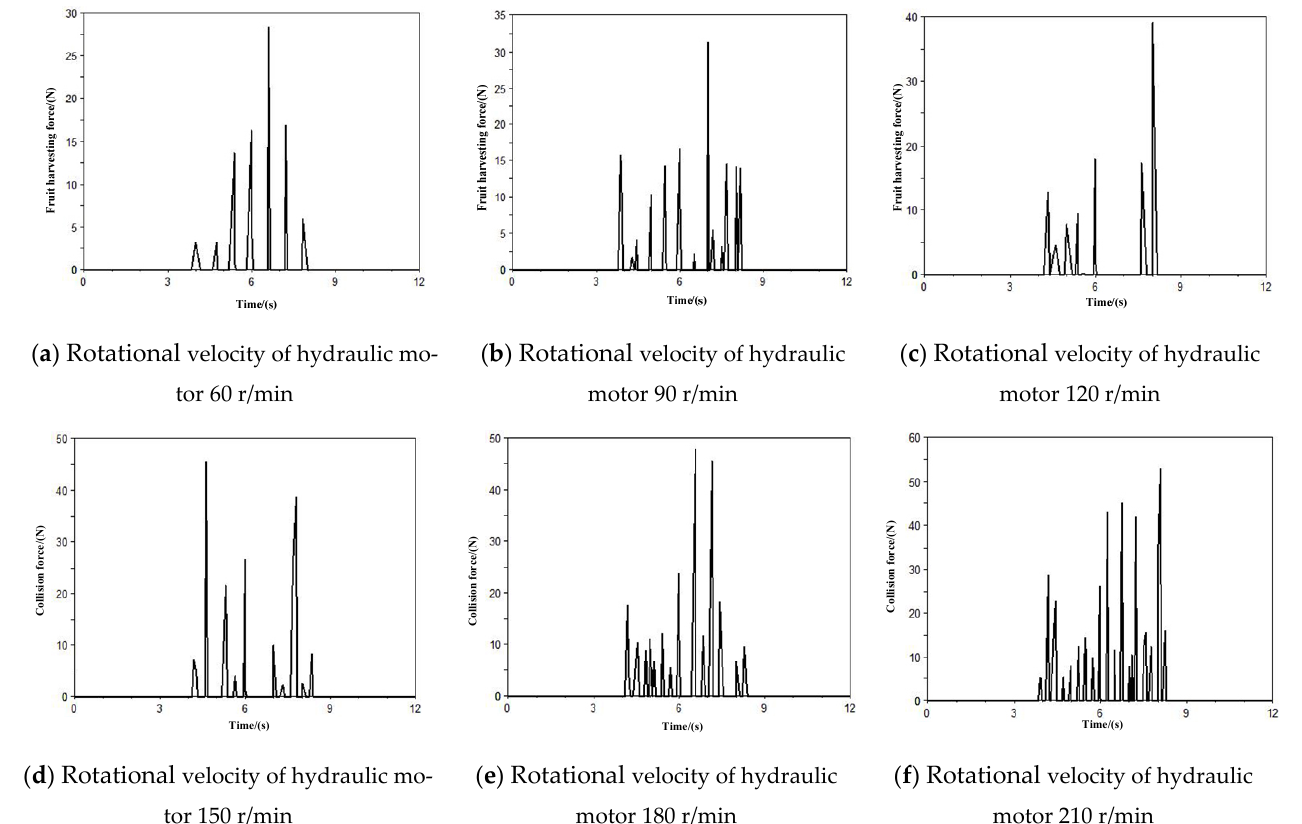
Figure 15. Analysis of the influence of rotational velocity on the harvesting collision force. It can be seen from Figure 15 that with a continuous increase in the output rotational velocity of the hydraulic motor of the harvesting system, the transient collision force F i ( t ) at the measurement point also increased, due to the fact that the increase in rotational velocity increased both the angular velocity ω and the angular acceleration of the finger rows when performing a reciprocating swing. The normal collision force F ni and the tangential collision force F τ i of the blueberry branch at the collision point A increased, according to Figure 4, and the collision force F i ( t ) at the measurement point also increased, according to Equation (1). In other words, the collision force F i ( t ) increased with an increase in the output rotational velocity of the hydraulic motor of the harvesting system.